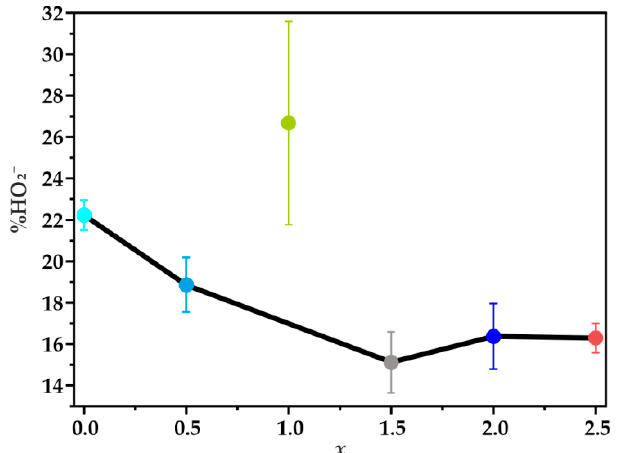
Figure 9. The average percentage of the HO − in the range of 0.1–0.5 V, calculated from the RRDE measurements performed in 0.1 M KOH solution at 800 rpm as a function of the iron content in the Fe x Co 3 − x O 4 spinel catalyst dispersed on the N,S-MPC support.